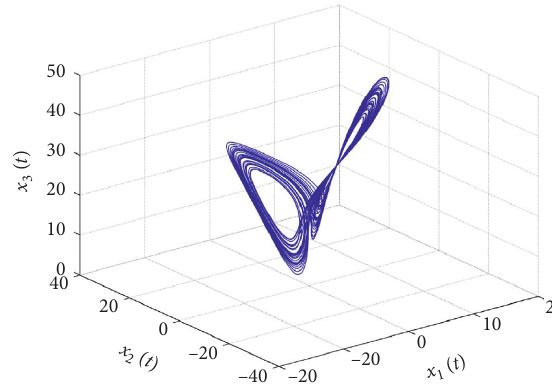
Figure 2: Trajectory of the chaotic system. Table 1: The maximum upper bound for τ